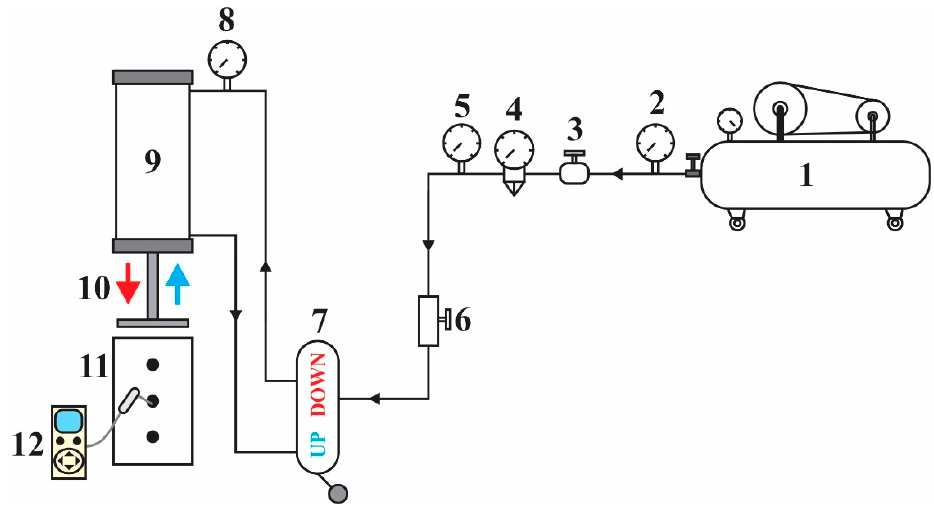
Figure 3. Schematic drawing of overall system: 1—Air compressor; 2—Analog pressure gauge; 3—Pressure relief valve; 4—Moisture drain valve; 5—Analog pressure gauge; 6—Safety valve; 7—Pneumatic lever valve (Up and Down); 8—Analog pressure gauge; 9—Steel cylinder chamber; 10—Steel piston; 11—PVC cylinder (sample vessel); and 12—Handheld transient heat dissipation device.